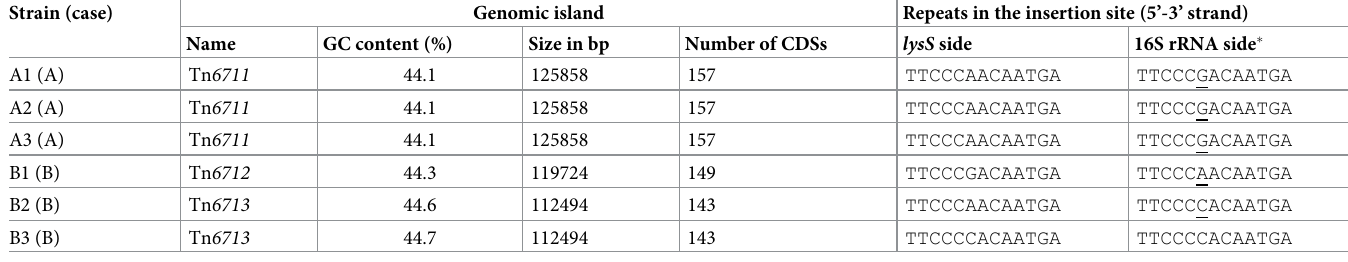
Table 3. Characteristics of the GIs of the Norwegian VanD-type VRE. Strain (case) Genomic island Repeats in the insertion site (5’-3’